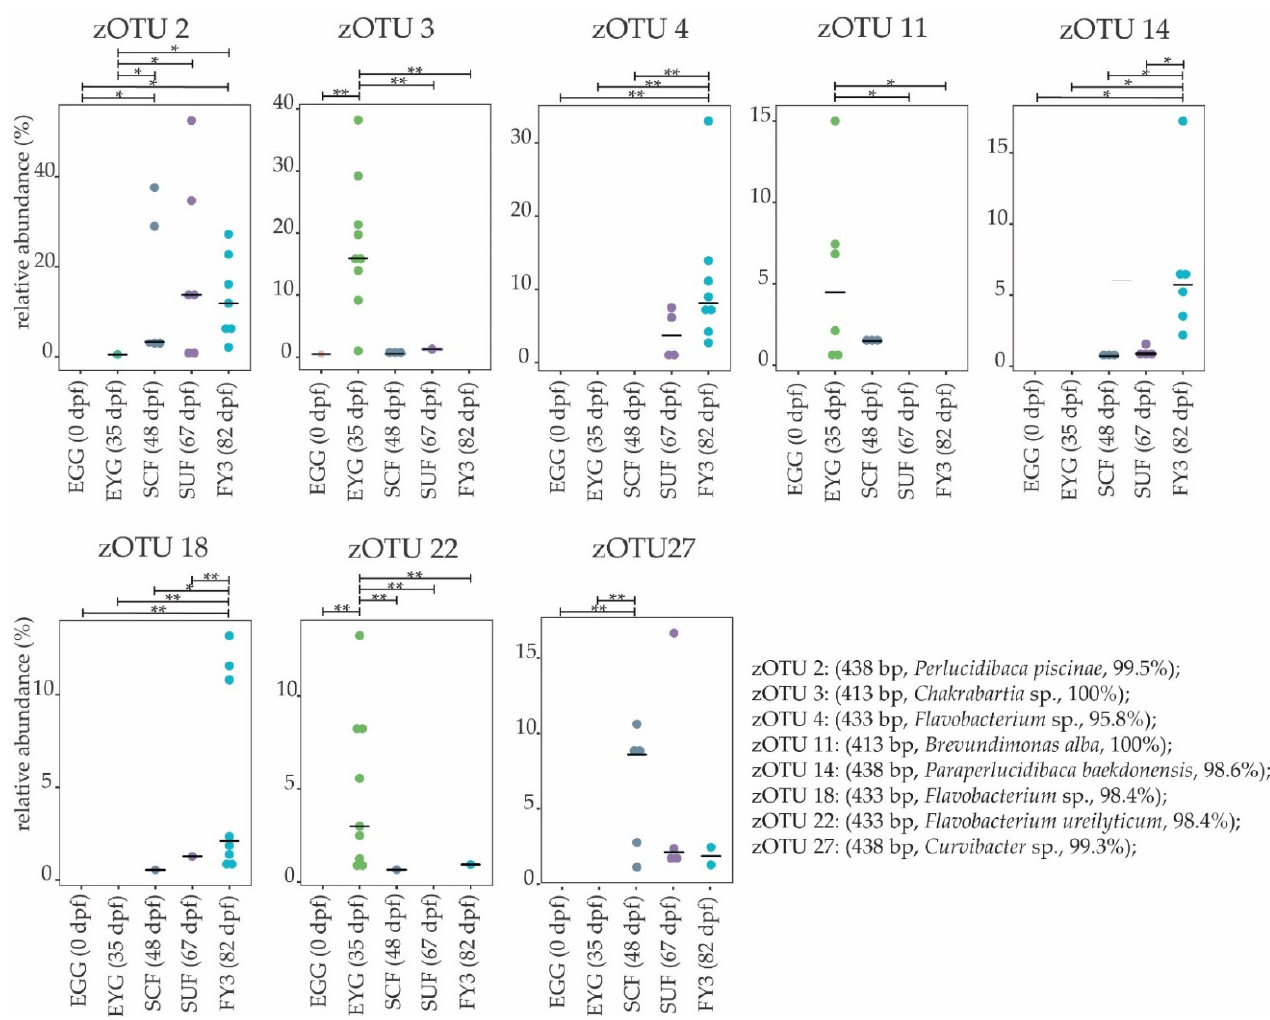
Figure 8. Molecular strains in the early developmental stages are shown. Boxplots depict the median (thick bar) and individual samples (points). Brackets above the individual boxplots indicate the significance level for pairwise comparison. zOTUs were identified by EzBiocloud; the sequence length, the closest relative taxon, and the sequence similarity score of zOTUs are shown in the order of appearance. EGG, egg; EYG, eyed egg; SCF, sac fry; SUF, swim-up fry; FY3, fry 82 dpf; dpf, days post fertilization. p value summary: * p ≤ 0.05, ** p ≤ 0.01.